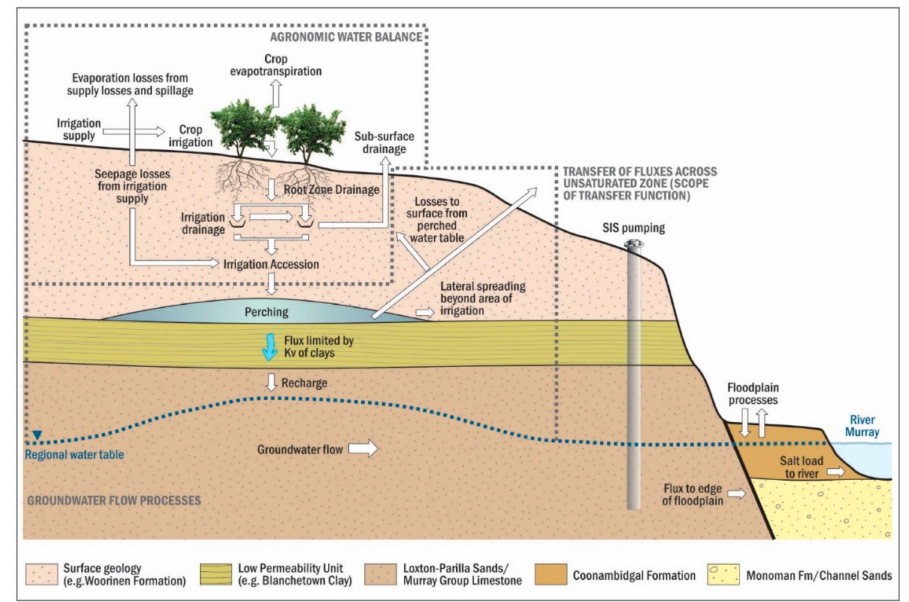
Figure 2. Conceptual model of groundwater returns to the Murray River from the Loxton and Bookpurnong irrigation districts, sourced with permission from [29]. Note that the Agronomic Water Balance used in this paper does not include irrigation drainage, which is addressed as an output of the transfer